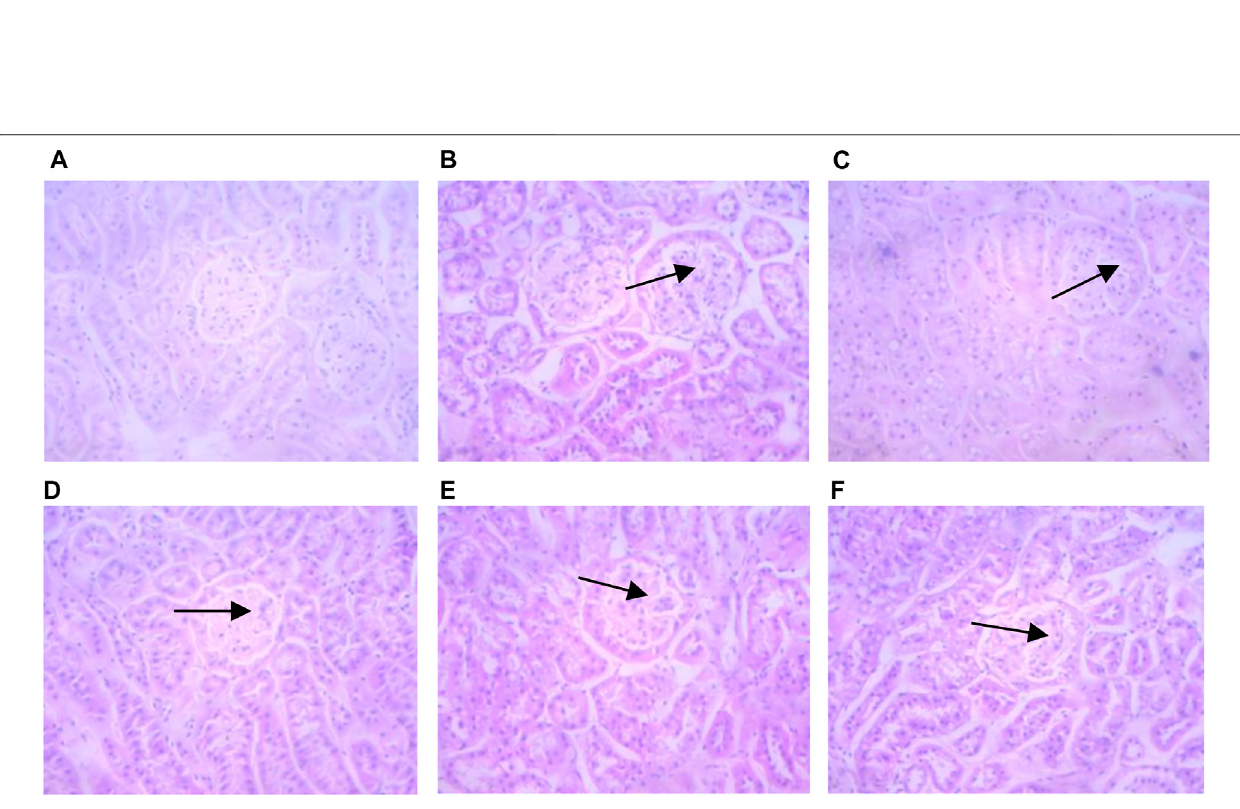
Frontiers in Pharmacology |